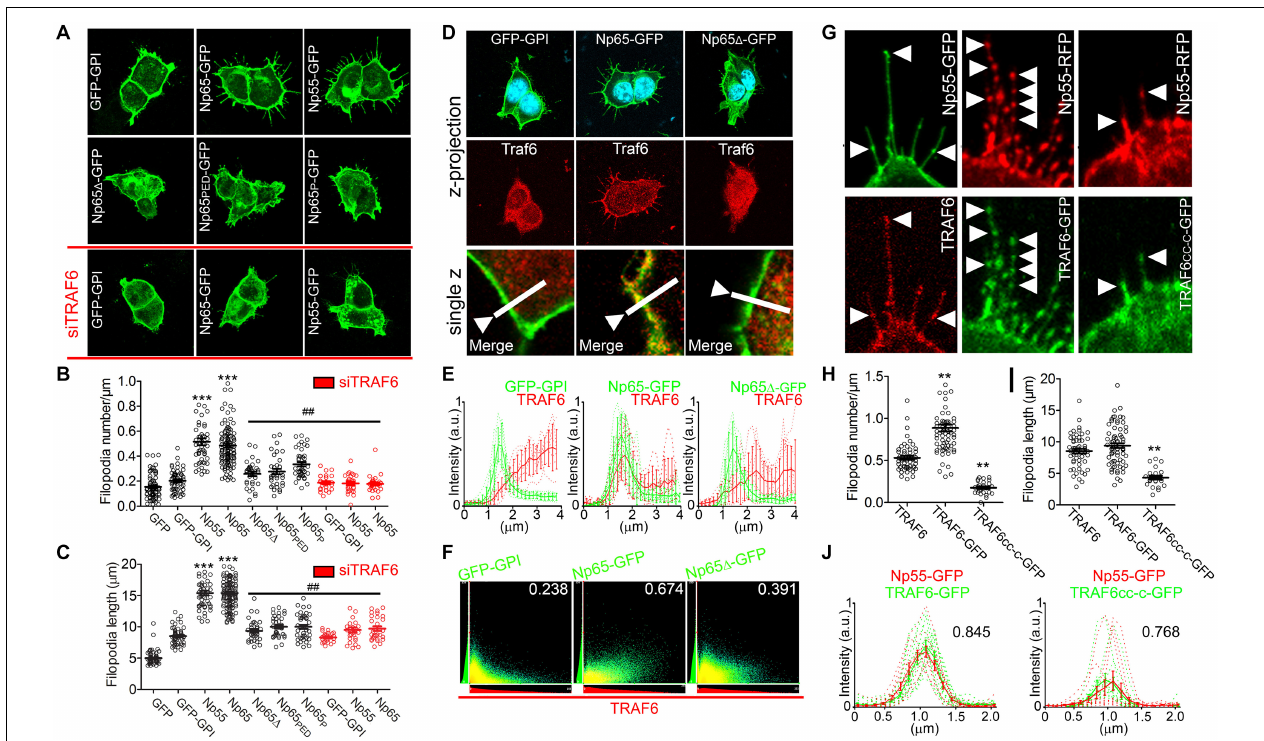
FIGURE 2 | Neuroplastin requires its TRAF6 binding motif and TRAF6 to promote filopodia formation. HEK cells were transfected with plasmids coding for either soluble GFP, membrane-attached GFP-GPI, DDEP insert-containing isoforms Np65-GFP or Np55-GFP, TRAF6 binding motif-deficient Np65 (cid:49) -GFP, Np65 PED -GFP (containing triple substitution to alanine in the TRAF6 binding motif) or Np65 P -GFP (with single substitution to alanine), full-length TRAF6-GFP or coiled coil-TRAF-C-GFP (TRAF6 cc − c -GFP). To knockdown endogenous TRAF6, cells were transfected with siRNA against TRAF6 or scrambled siRNA before the transfection with plasmids. After 48 h, cells were fixed with methanol and immunostained with anti-GFP rabbit antibody overnight and with an Alexa-488 secondary antibody. Alternatively, cells were additionally stained with an anti-TRAF6 rabbit antibody followed by a Cy3-conjugated secondary antibody and DAPI. Data and images from N = 4–6 independent experiments. (A–C) Deletion or mutations of the TRAF6 binding motif of neuroplastin or knock-down of endogenous TRAF6 decrease neuroplastin capacity to promote filopodia. (A) Scale bar = 10 µ m. (B) Filopodia number per micron of plasma membrane (GFP = 0.15 ± 0.01, n = 70; GFP-GPI = 0.20 ± 0.01, n = 59; Np55-GFP = 0.51 ± 0.02, n = 51; Np65-GFP = 0.48 ± 0.01, n = 126; Np65 (cid:49) -GFP = 0.25 ± 0.01, n =